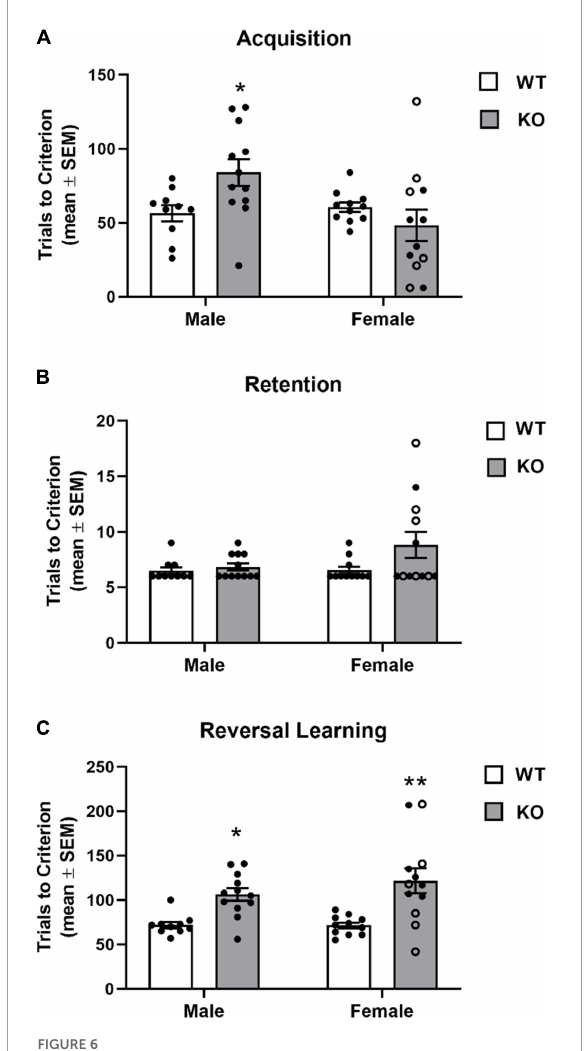
FIGURE6 Acquisition and reversal learning of a spatial discrimination task (80/20 probabilistic learning). (A) Mean ( ± SEM) trials to criterion on acquisition. Male Fmr1 -knockout (KO) mice, but not female Fmr1 -KO mice required significantly more trials to criterion on acquisition than wildtype (WT) male and female mice. (B) Mean ( ± SEM) trials to criterion on retention. WT and Fmr1 -KO mice required similar number of trials to criterion in retention. (C) Mean ( ± SEM) trials to criterion on reversal learning. Male and female Fmr1 -KO mice required more trials to reach criterion compared to that of WT male and female mice. * p < 0.05 vs. WT male and female mice; ** p < 0.01 vs. WT male and female mice. In the female Fmr1- KO group, • , heterozygous mice and ◦ , homozygous